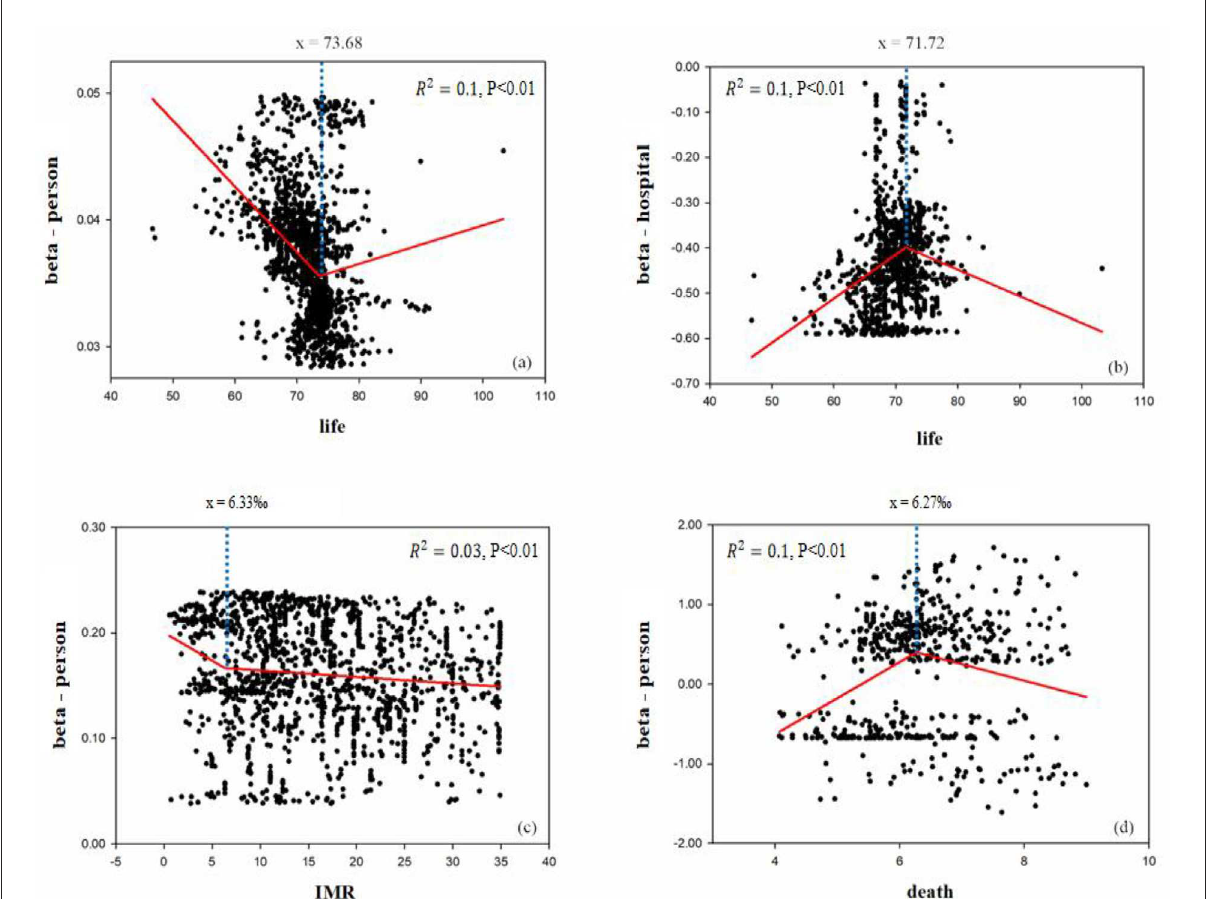
FIGURE7 Impact on population health of health resource enhancement, 2000–2010. Beta coefficients ( p < 0.05); y = beta coefficient (in 2010)/beta coefficient (in 2000) for Y-axis; X-axis was life expectancy data (in